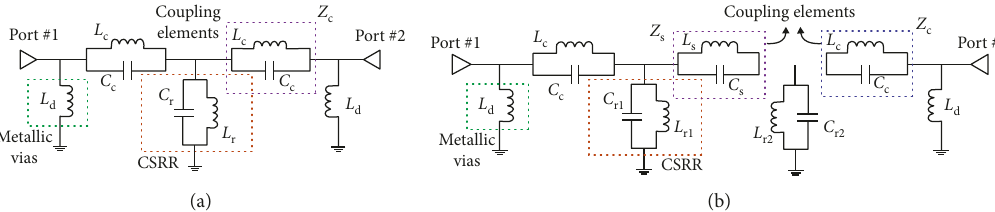
Figure 16: (a) Equivalent circuit model for the base layouts introduced in Section 2. (b) Equivalent circuit corresponding to the first resonator.